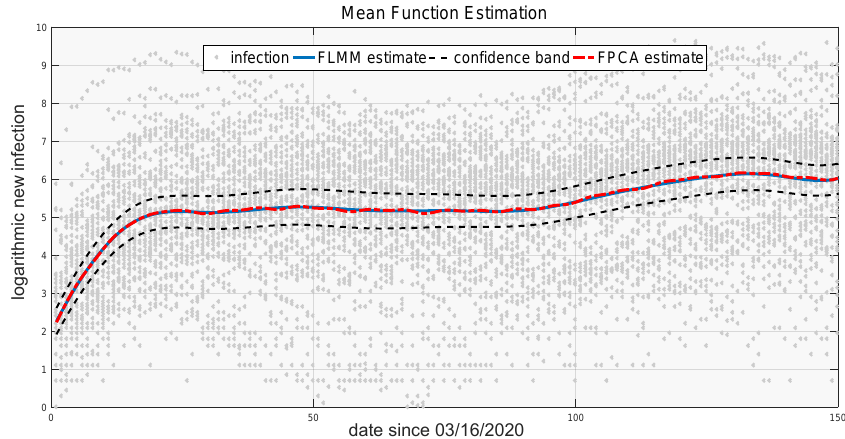
Figure 5. Fitted mean functions of daily infection via FPCA and proposed FLMM.